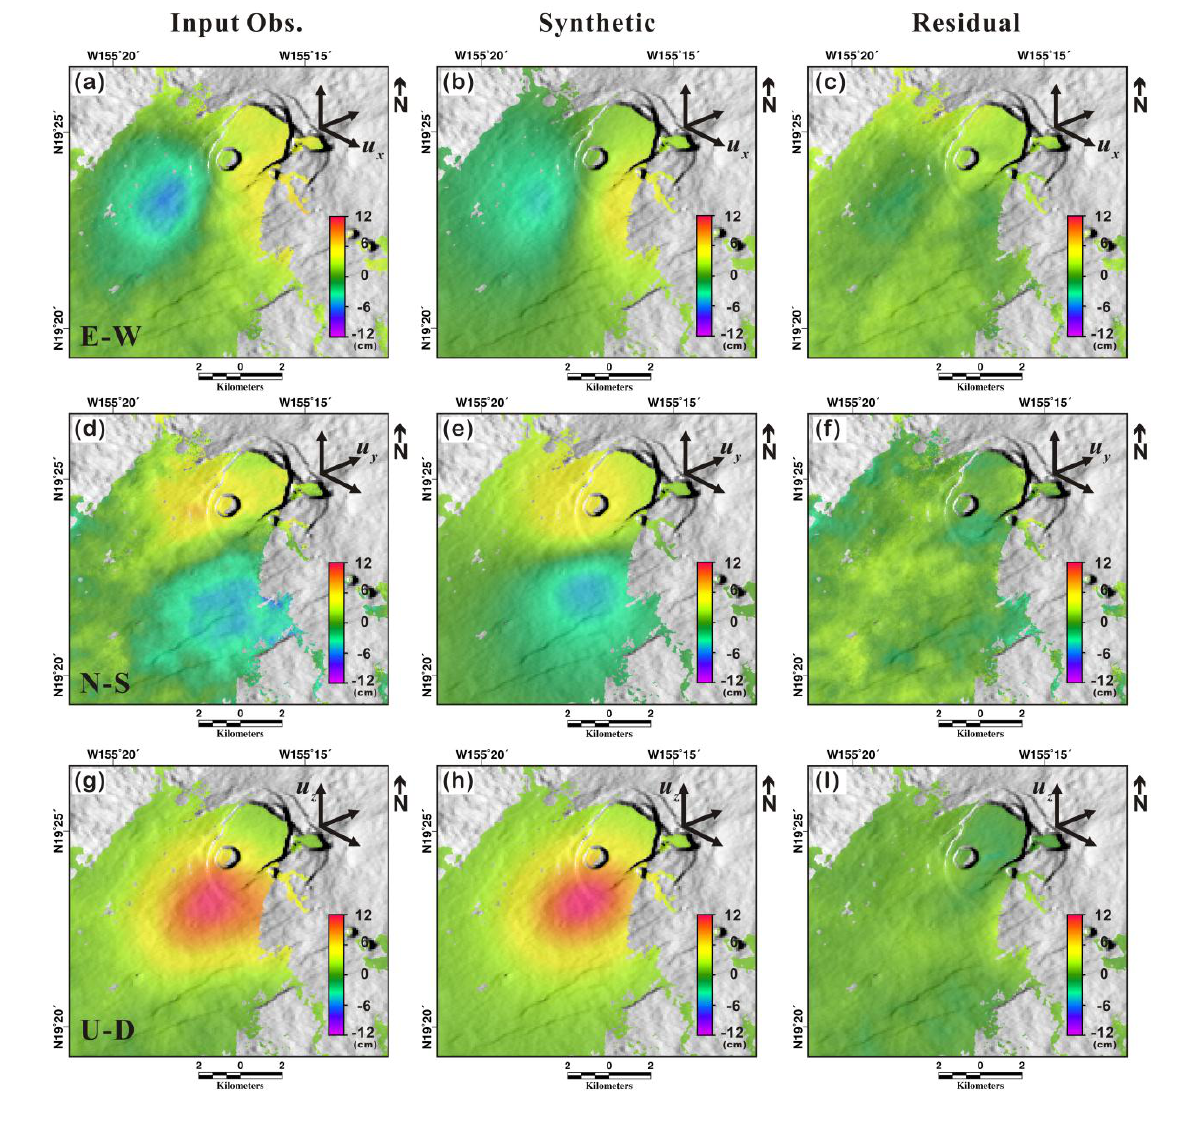
Figure 7. Inversion results of the prolate spheroid model for the magma source below Kīlauea’s summit using 3D measurements. The first row shows the ( a ) observed, ( b ) synthetic, and ( c ) residual deformation of the east component. The second row shows the ( d ) observed ( e ) synthetic, and ( f ) residual deformation of the north component. The third row shows the ( g ) observed, ( h ) synthetic, and ( i ) residual deformation of the up